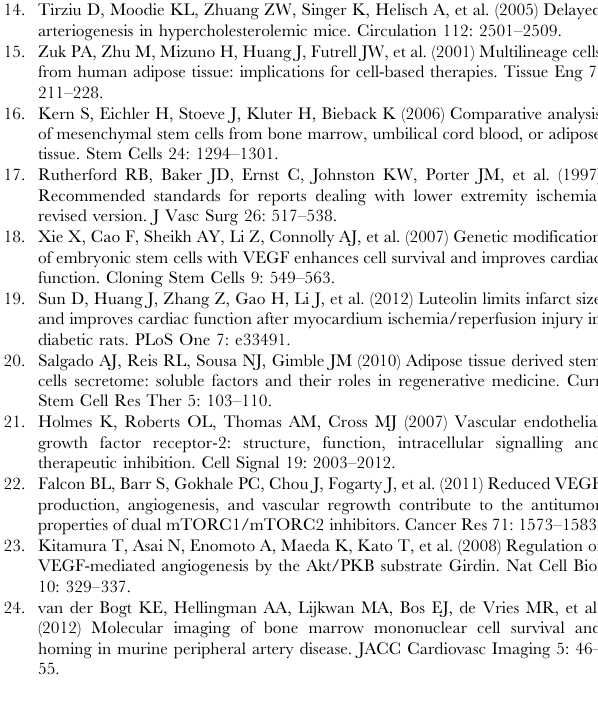
Figure S1 Bioluminescence/fluorescence imaging (BLI/FRI) for Tg( Fluc - egfp ) mice. Colored scale bars represent Fluc biolumines-